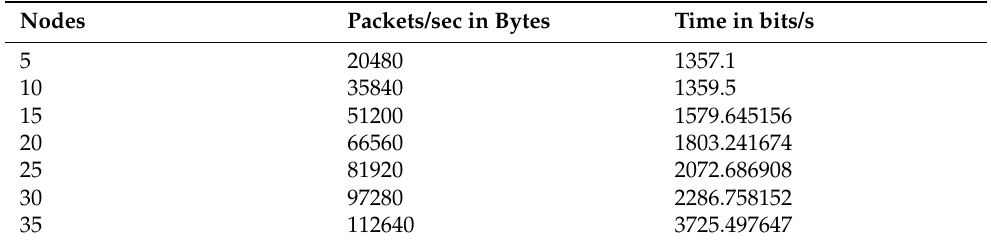
Table 4. Total transmission time for nodes using the ZMAC scheme when an attack is introduced.